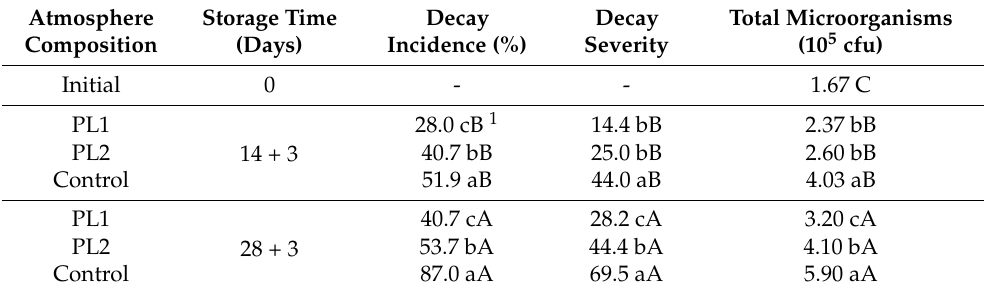
Table 4. Decay incidence, decay severity and total microorganisms of Bursa Siyahi fig cultivar under palliflex system during the cold storage + 3 days at